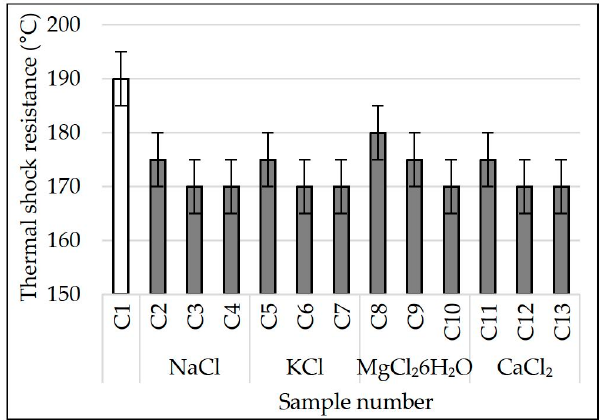
Figure 8. Thermal shock resistance of samples. White square – without chlorides; Gray squares – with chlorides.